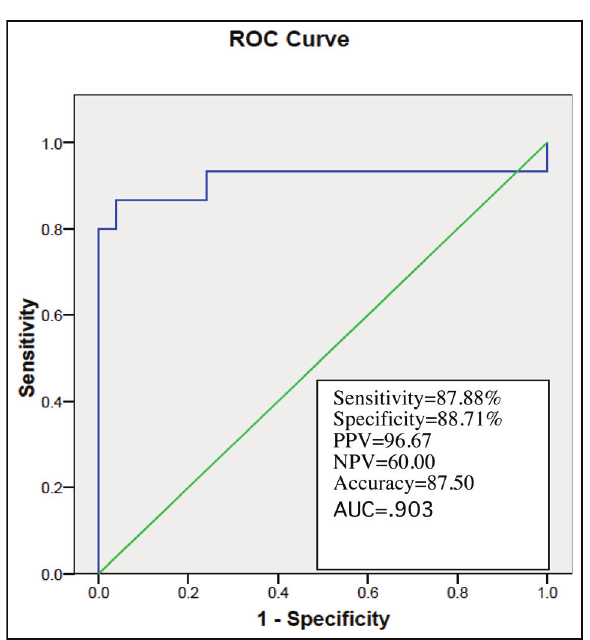
Receiver operating characteristic (ROC) curves of oxygen desatura- tion index (ODI) parameters for the diagnosis of mild and moderate obstructive sleep apnea (OSA) patients with thresholds apnea hypo- pnea index (AHI) = 5 –